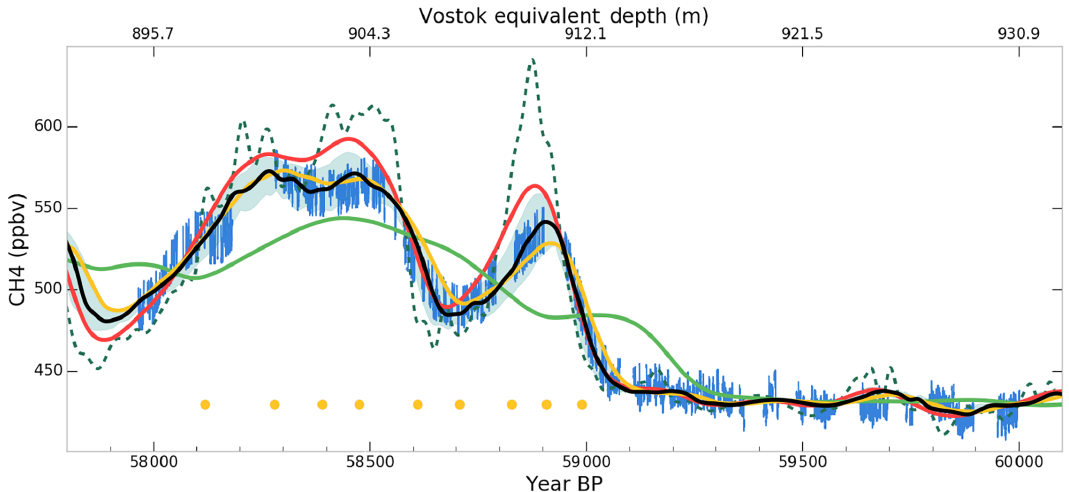
Figure 5. WDC CH 4 signal convolved with different GADs: the Dome C GAD estimated for the Bølling–Allerød by Köhler et al. (2015) in red, the Dome C GAD estimated for the Last Glacial Maximum by Köhler et al. (2011) in green, a lognormal fit to the modern Vostok GAD from Witrant et al. (2012) in yellow, and the Vostok DO-17 GAD estimated in Sect. 5.2 in black (uncertainty envelope shown in light blue). The WDC record (Rhodes et al., 2015) is displayed in dashed green, and the CFA Vostok measurements in blue. Yellow dots show the tie points used to match the WDC and Vostok